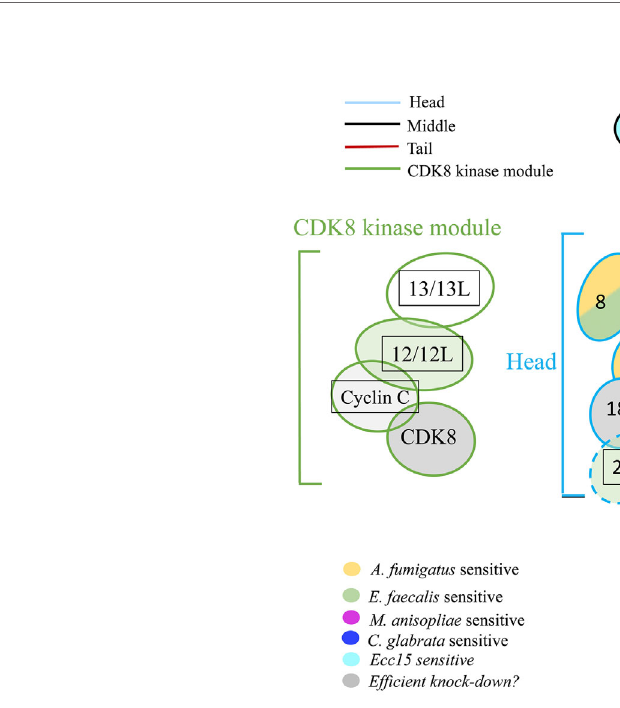
FIGURE 7 | Roles of Mediator complex modules against infectious pathogens. The Mediator complex is composed of a central complex and of the CDK kinase module (CKM). The central complex has three modules: the head (light blue circumference), the middle (black circumference), and the tail (red circumference). Med14 constitutes a scaffolding subunit indicated by dark blue. The CKM (green circumference) consists of four subunits: CDK8 (or its paralog CDK19 ), Med12 (or its paralog Med12L ), Med13 (or its paralog Med13L ), and Cyclin C. Subunits sensitive to A. fumigatus are shown in yellow; subunits sensitive to E. faecalis in green, light green when the phenotype is uncertain due to a lethality observed in the A. fumigatus experiments (Med12); subunits sensitive to M. robertsii natural infection are displayed in dark purple, light purple when the phenotype is uncertain; subunits sensitive to M. robertsii injection are shown in orange (only Med17 and Med31 RNAi fl ies have been tested); subunits sensitive to C. glabrata infection are pictured in dark blue whereas subunits sensitive to Ecc15 infection are light blue. Lines for which the RNAi may not be effective are displayed in gray; a lighter gray indicates lines in which pupae developed upon continuous expression of the RNAi transgene during development, yet did not yield any adult fl ies (metamorphosis phenotype). Lines that yielded a lethal phenotype in the uninfected controls in the A. fumigatus experiments when gene expression was inhibited in the adult display a boxed subunit number, which is dashed when sensitivity was observed in the wounding (PBS-injected) but not the uninfected